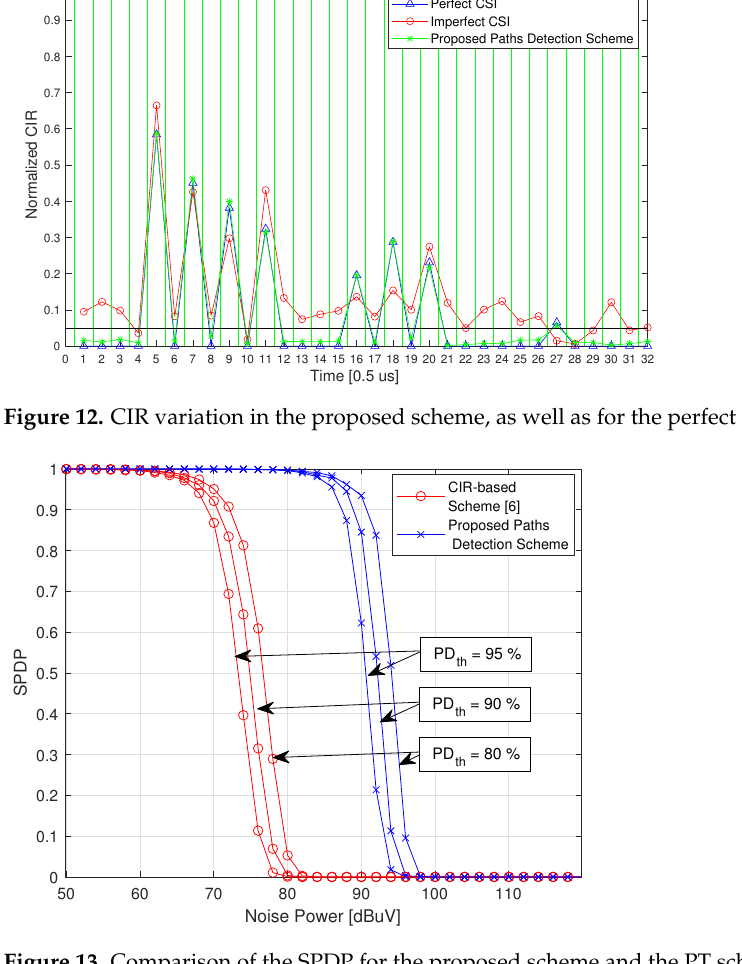
Figure 13. Comparison of the SPDP for the proposed scheme and the PT scheme vs. noise power, for N obs = 100, and for different values of path detection threshold (PD th